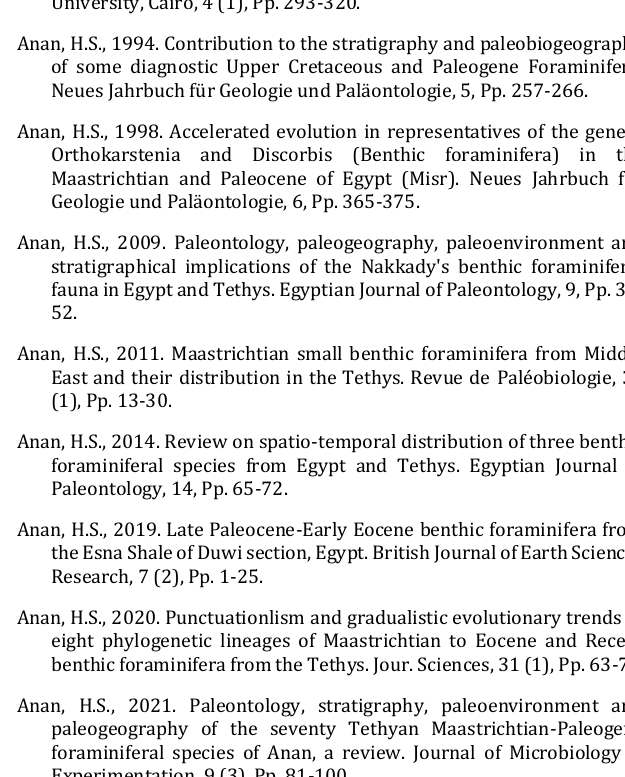
Figure 7: The paleogeographic map of the Maastrichtian showing the open Northern and Southern Tethys, with the detection of diagnostic Duwi section (Egypt) in the Southern Tethys.